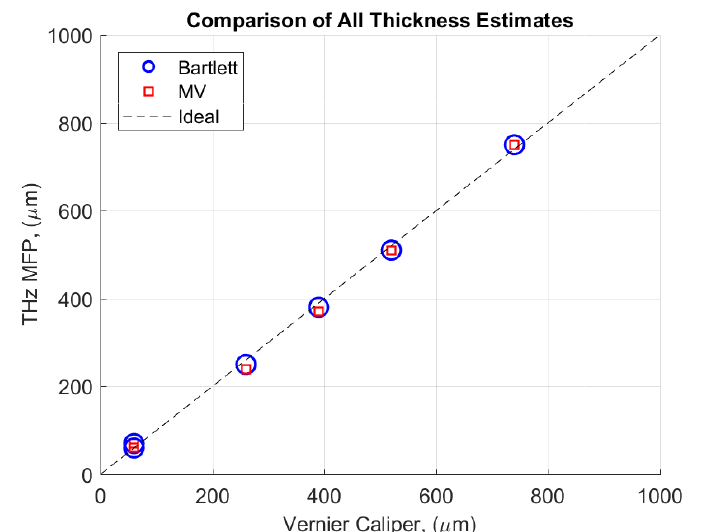
Figure 7. For each of the Vernier caliper measurements listed in Table 2, the corresponding thickness estimates from THz MFP with the Bartlett and MV processors are plotted as blue circles and red squares, respectively. The dashed line represents an ideal case of equality of the Vernier caliper measurement and the THz MFP thickness estimate. Thus, all of the measurement data from the THz MFP approach is in close agreement with the Vernier caliper